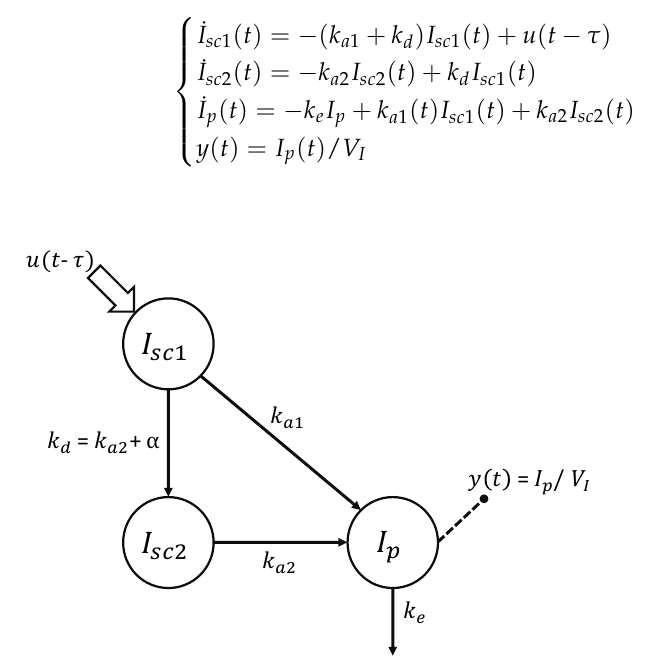
Figure 3. Compartmental representation of the model describing the subcutaneous absorption of fast-acting insulin [12]. Model compartments are represented with circles, and the fluxes are indicated with arrows. Signals u and y represent the subcutaneous insulin administration and plasma insulin concentration,